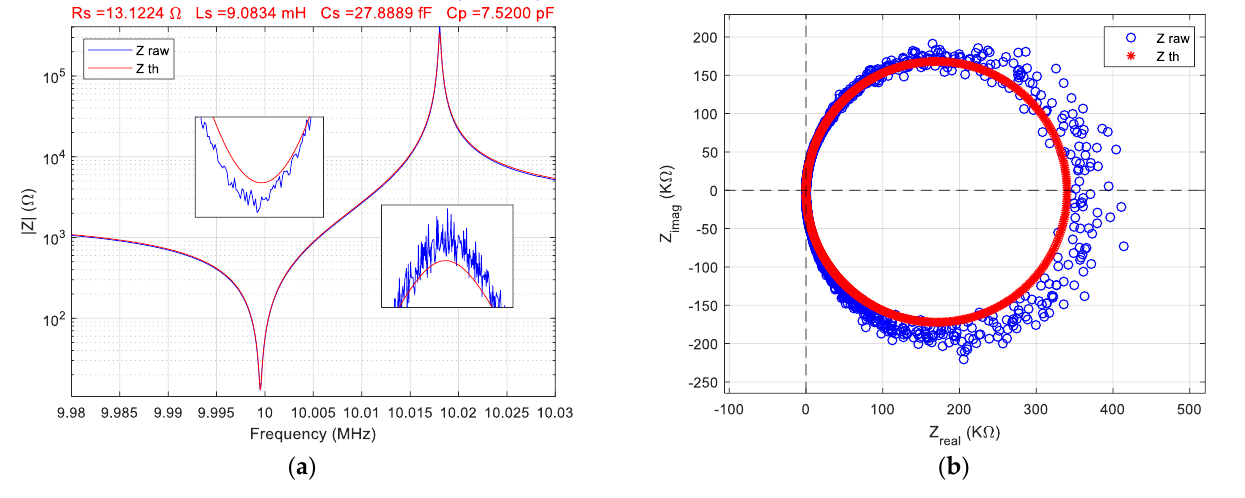
Figure 9. ( a ) Bode plot, and ( b ) Nyquist plot of the BVA model parameters for QCM sensor fitted with Levenberg – Marquardt algorithm (theoretical impedance, 𝑍 𝑡ℎ